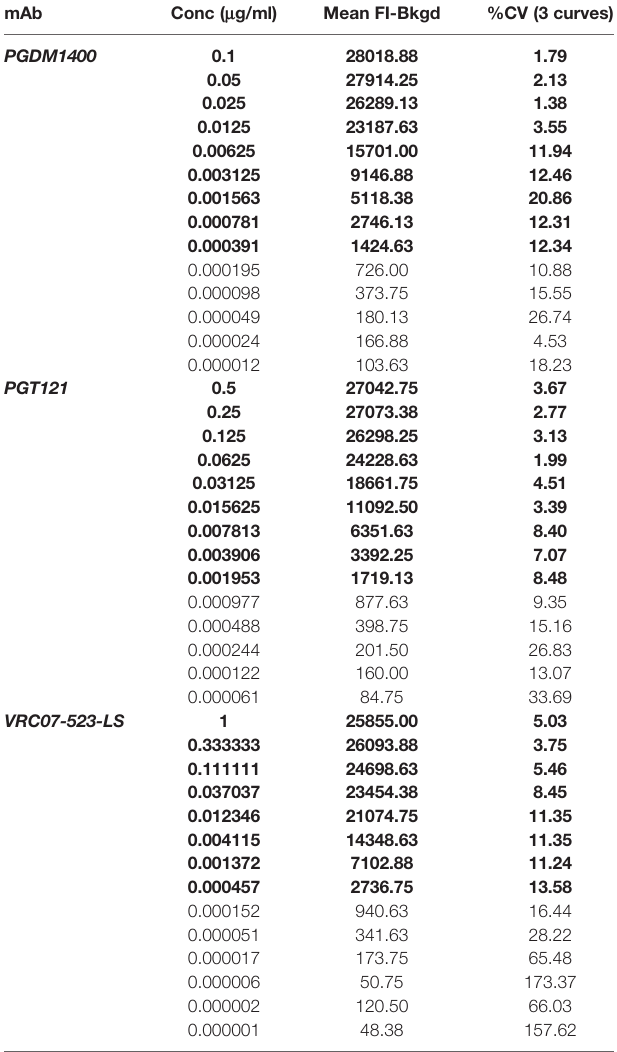
TABLE 3 | Intermediate precision of PGDM1400/PGT121/VRC07-523-LS standard